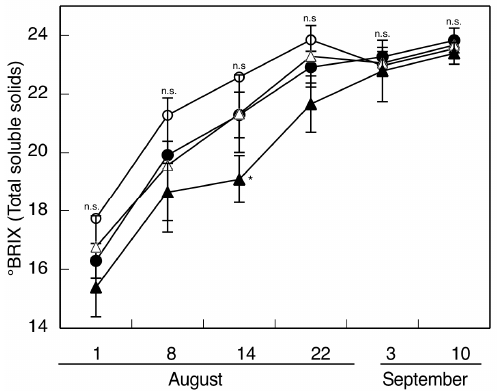
Figure 1. Evolution of TSS following veraison (in days). Treatments: ( ● ) rainfed without thinning (H1), ( ○ ) rainfed with thinning (L1), ( ▲ ) irrigated without thinning (H2), and ( △ ) irrigated with thinning (L2). The data are the means ± SD of at least 10 replicates obtained from 5 different experiments. According to Friedman test, significant differences ( p < 0.05) are indicated by * and no significant differences are indicated as